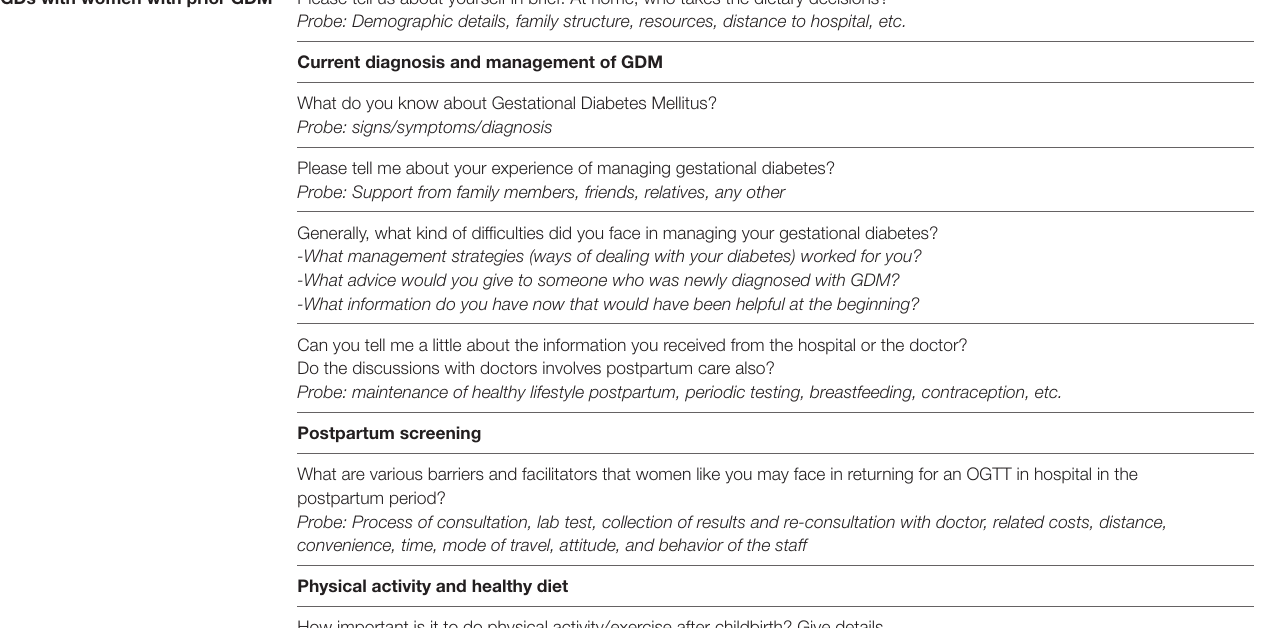
FGDs with women with prior GDM Please tell us about yourself in brief. At home, who takes the dietary decisions? Probe: Demographic details, family structure, resources, distance to hospital,